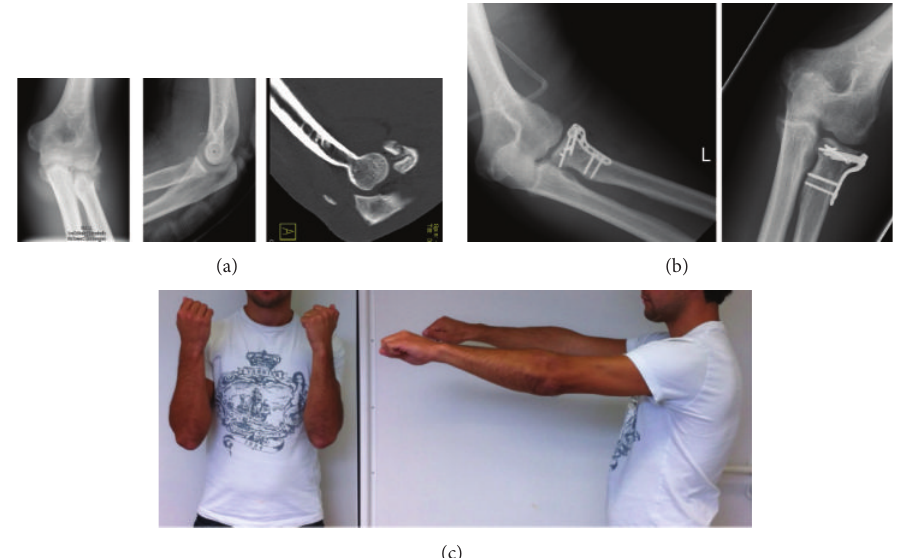
Figure 6: (a) X-rays illustrating radial head multifragmentary fracture. One slice of the CT scan proves the bony tendon tear of the triceps by a young sports student, who was suffering from an elbow dislocation. (b) Postoperative X-rays demonstrating radial head reconstruction and stabilization. The bony tear of the triceps tendon was sutured to the olecranon tip. (c) Forty-eight weeks after trauma, the young athlete was not able to straighten the left elbow. Full range of motion was restored within 6 weeks by applying oral cortisone therapy with Prednisolon 5mg tablets in decreasing dosage as described in Table